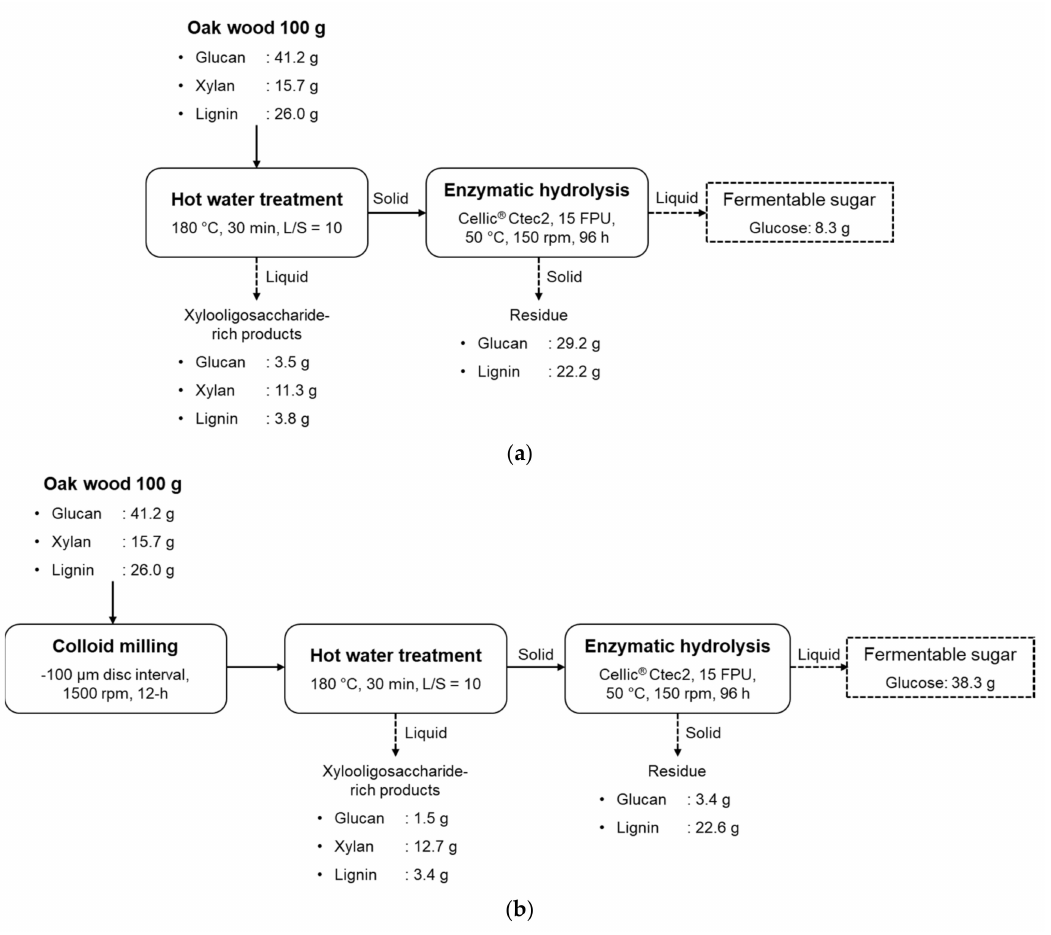
Figure 9. Mass balances of sugar production processes using two different pretreatment methods ( a ) HW-only pretreatment and ( b ) CM-HW